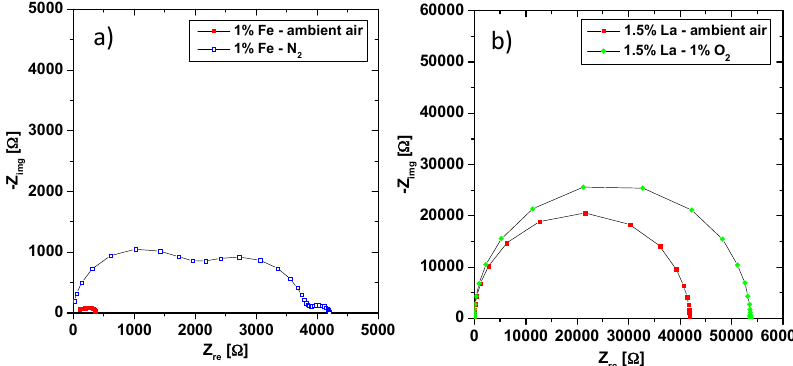
Figure 7. Partial pressure dependence of impedance spectra of 1% Fe-doped ( a ) and 1.5% La-doped ( b ) samples at 560 °C. Both show characteristics of hole conducting material, having a higher resistance for lower oxygen partial pressure.